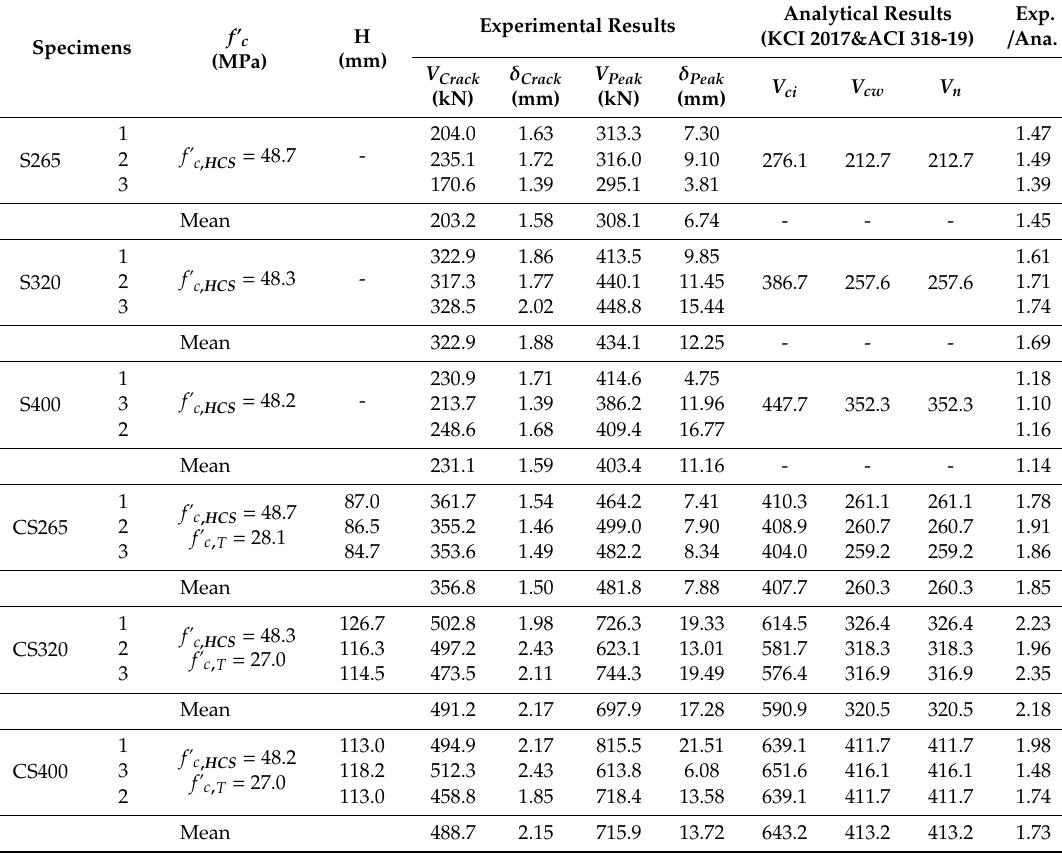
Table 3. Comparison between analytical and experimental